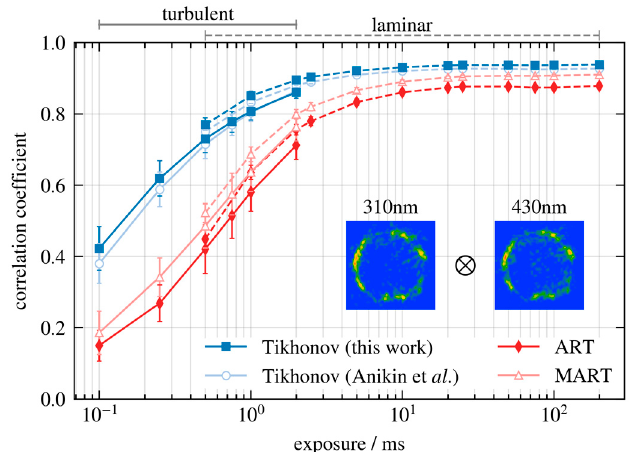
Figure 3. Normalized cross-correlation between simultaneously acquired distributions of OH* and CH* in turbulent (solid) and laminar (dashed) methane/air diffusion flames as a function of image exposure time. Comparison of different reconstruction methods: Tikhonov regularization based on Equation (3) and according to Anikin et al. [4] (Equation (5)), as well as the algebraic reconstruction technique (ART, Equation (6)) and the multiplicative algebraic reconstruction technique (MART, Equation (7)).